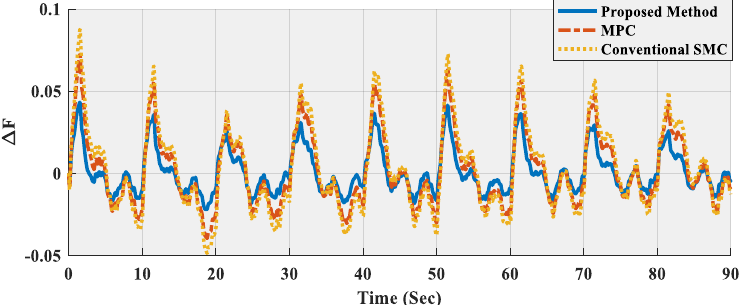
Figure 7. Curves of the MG response with the application of WPG and PV.